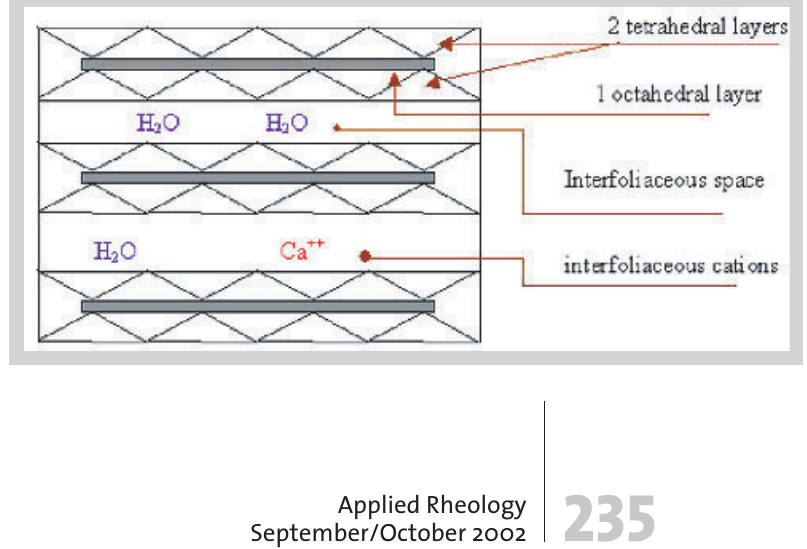
Figure 1: Layers disposition of 2:1 type for montmoril- lonite